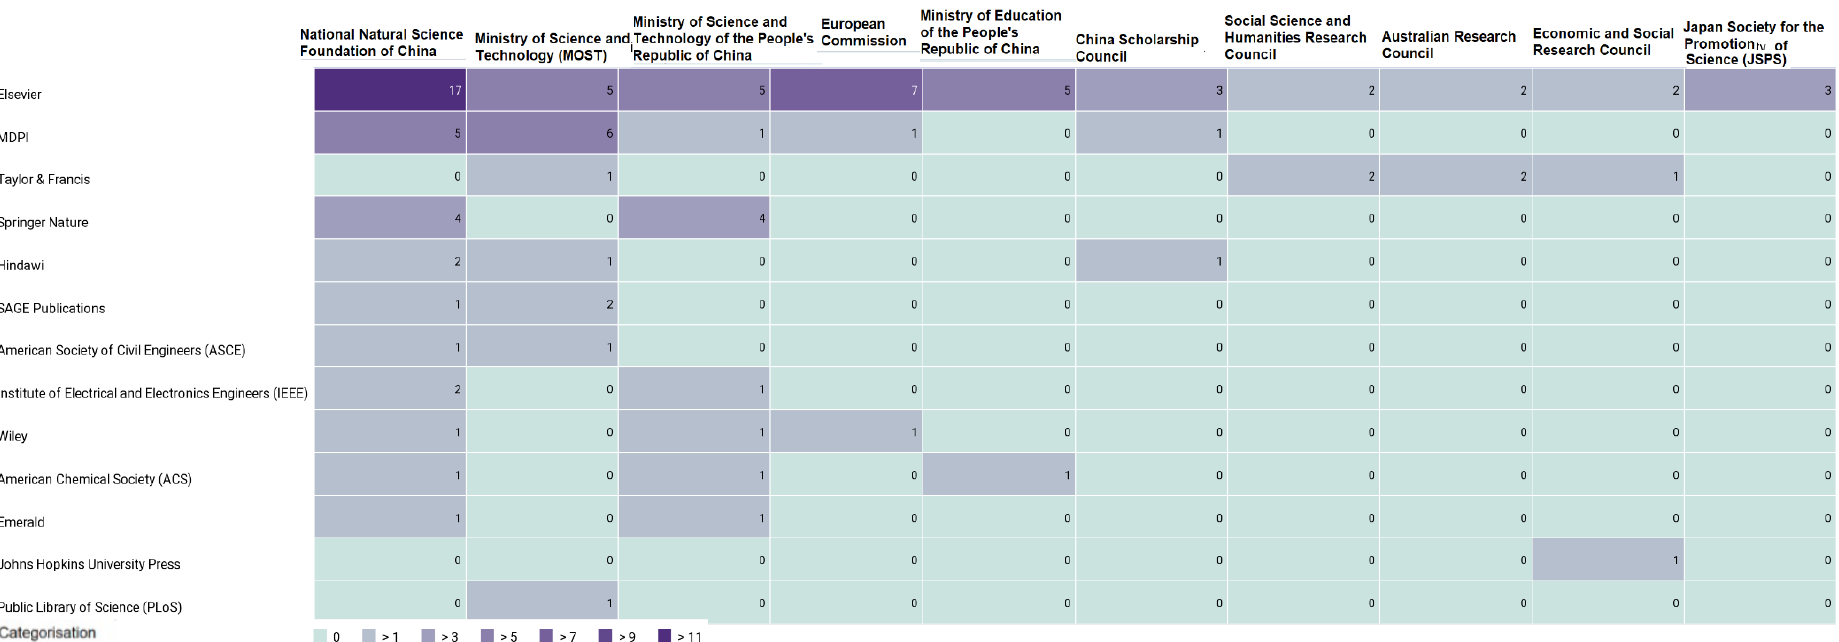
Figure 10 . Peering Funders Ministry and Regions in Aerotropolis .